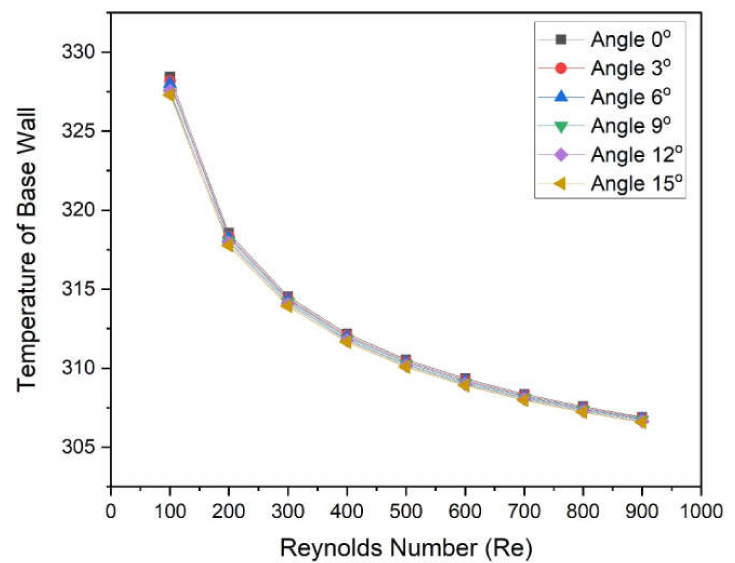
Figure 10. Variation in the temperature of the base wall of microchannel heat sinks with Reynolds numbers for different angles.